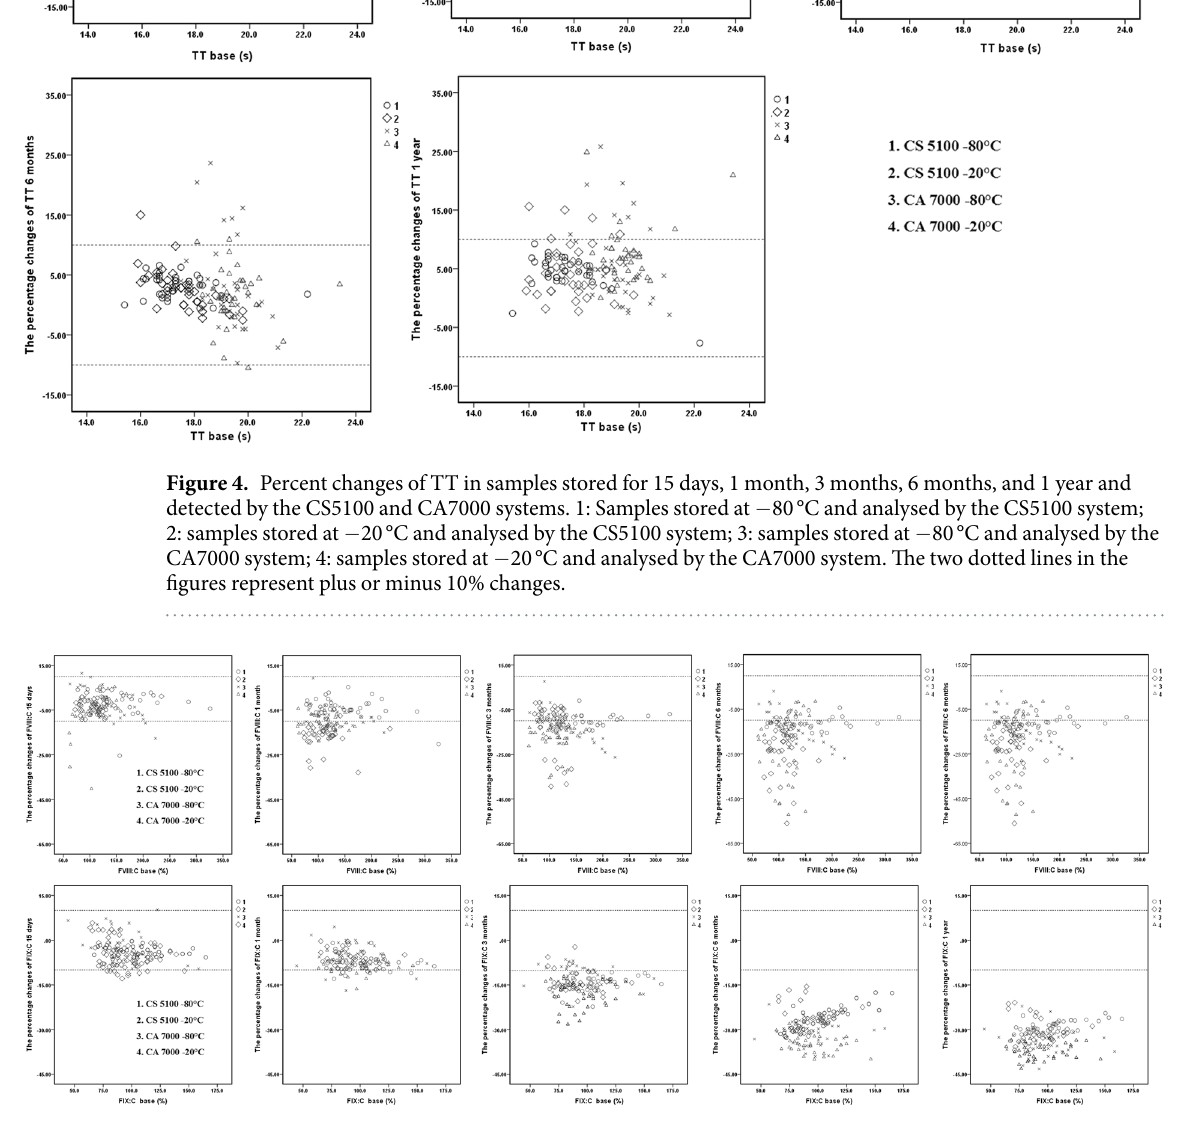
Figure 5. Percent changes of FVIII:C and FIX:C in samples stored for 15 days, 1 month, 3 months, 6 months, and 1 year and detected by the CS5100 and CA7000 systems. 1: Samples stored at − 80 °C and analysed by the CS5100 system; 2: samples stored at − 20 °C and analysed by the CS5100 system; 3: samples stored at − 80 °C and analysed by the CA7000 system; 4: samples stored at − 20 °C and analysed by the CA7000 system. The two dotted lines in the figures represent plus or minus 10%